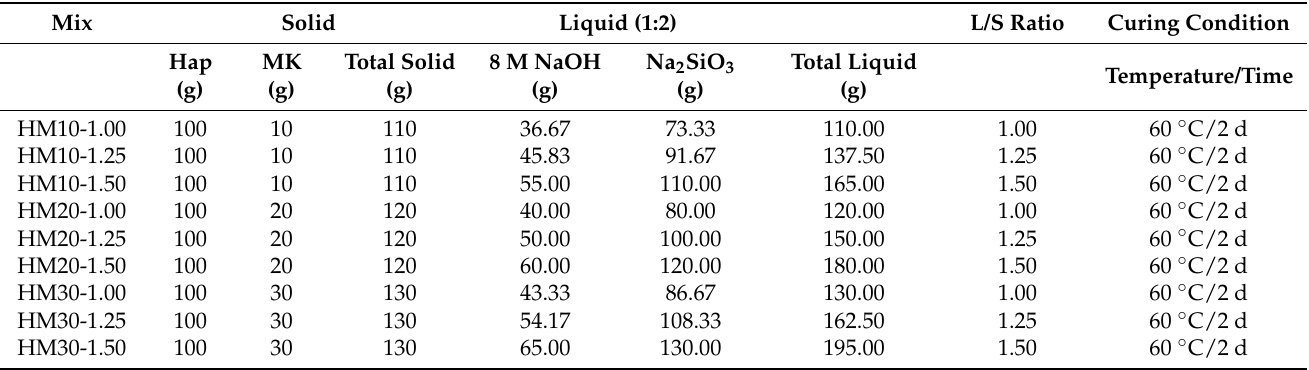
Table 1. Mix design inputs used in the experiment.